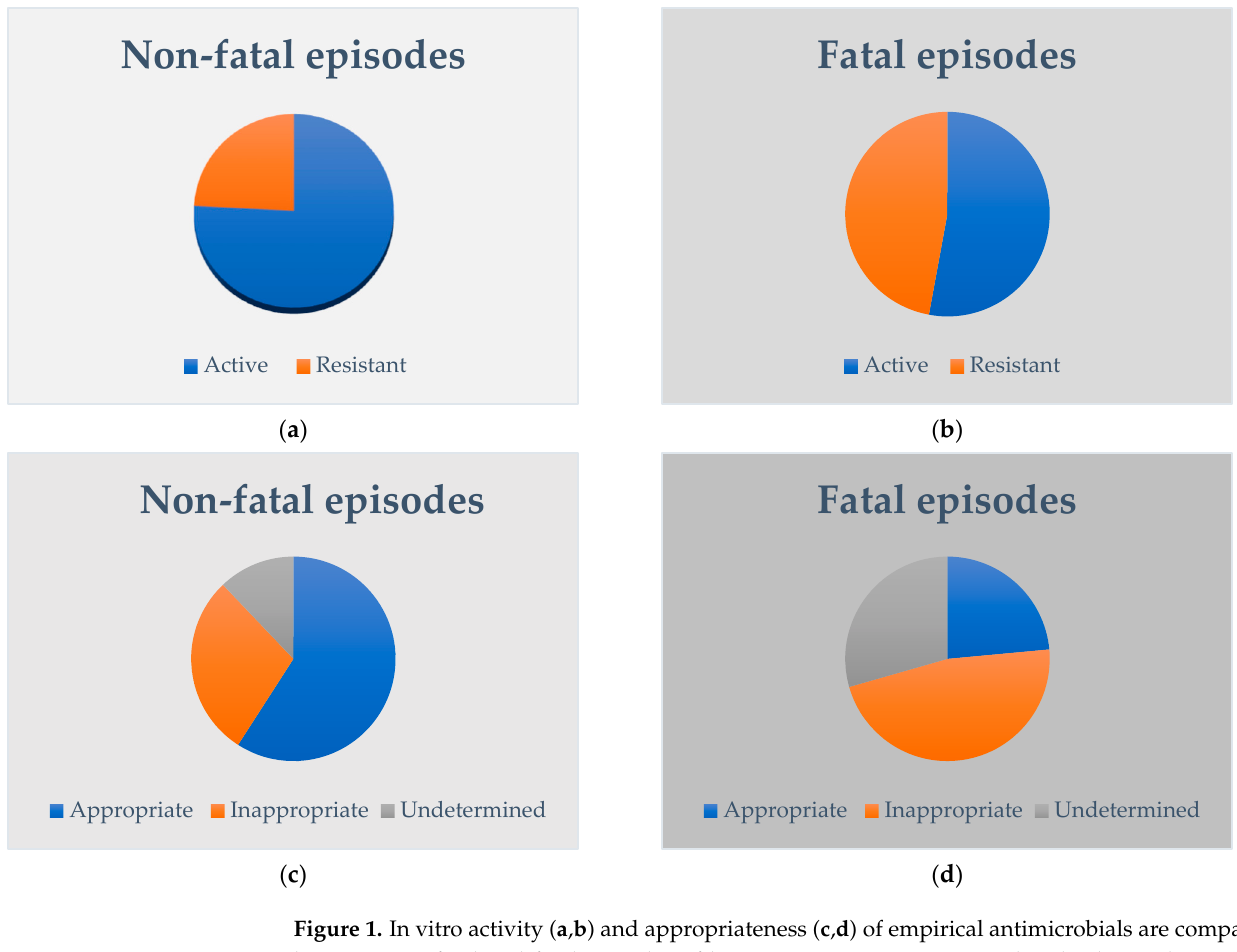
Figure 1. In vitro activity ( a , b ) and appropriateness ( c , d ) of empirical antimicrobials are compared between non-fatal and fatal episodes of late-onset sepsis among very low birth weight preterm infants.